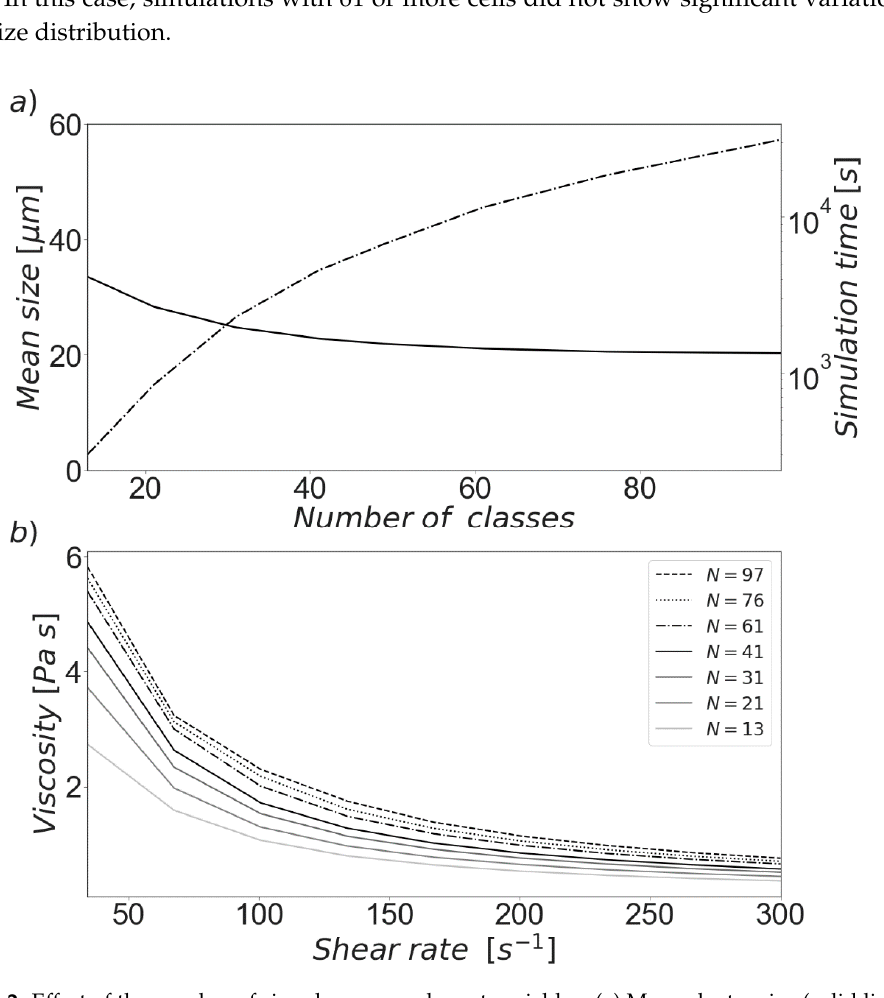
Figure 2. Effect of the number of size classes on relevant variables. ( a ) Mean cluster size (solid line) vs total simulation time (dash-dotted line) with a shear rate of 300 s − 1 . ( b ) Viscosity as a function of shear rate for different number of size classes.